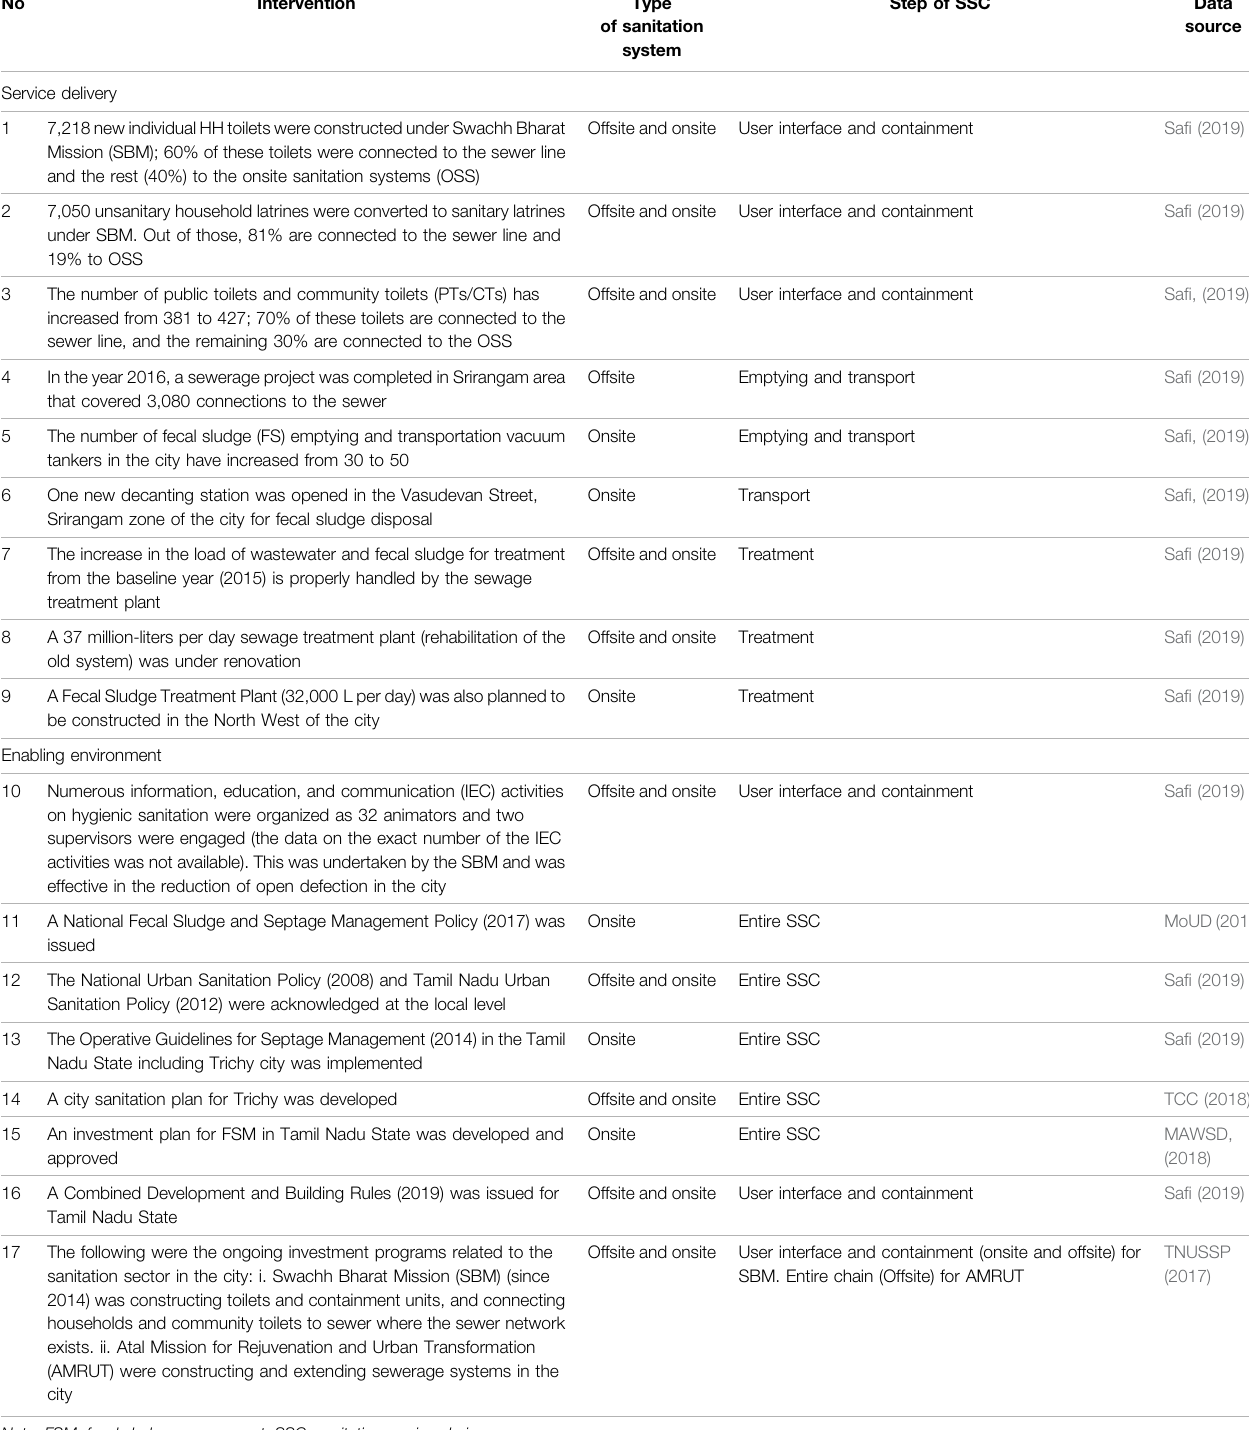
TABLE 1 | Sanitation interventions in Trichy from 2015 to